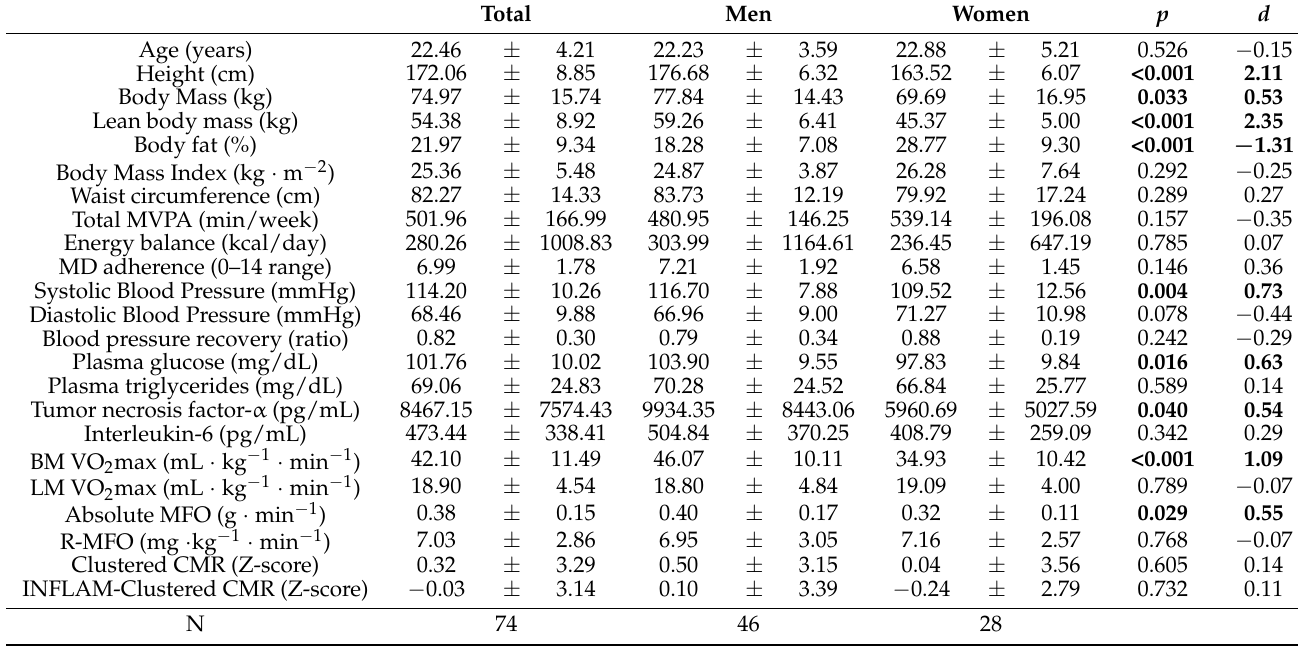
Table 1. General characteristics of total sample and differences between men and